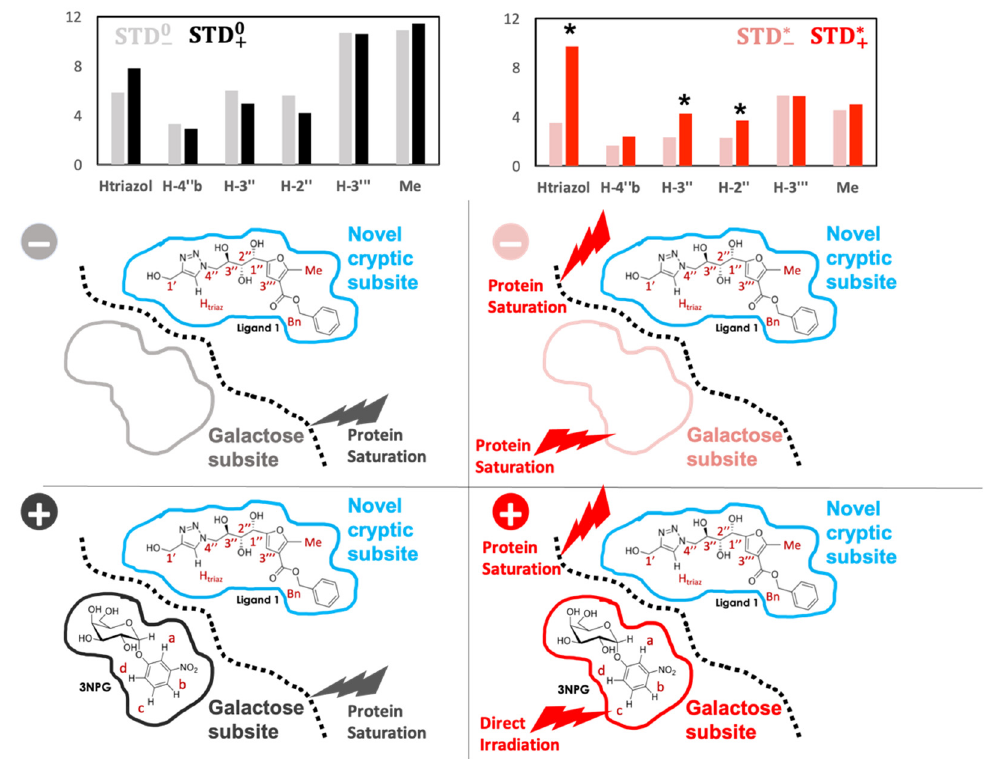
Figure 6. Quantitation of the STD 0 and STD* results (left and right panels, respectively; δ 0 = 0 ppm (in black) and at δ * = 7.27 ppm (in red)) for the IL-STD NMR study of the binding of 3NPG and 1 to CTB. Dark and light black bars show the STD 0 values in samples containing the binary (STD 0 − , 3NPG absent) or the ternary complex (STD 0 + , both ligands present), whereas dark and light red bars show the STD* values in samples containing the binary (STD ∗ − ) or the ternary complex (STD ∗ + ). Asterisks mark the STD intensities significantly increased under direct irradiation of 3NPG. Panels at the bottom represent schematically the 4xSTD NMR experiments. η ( IL − STD ) values are reported in Table S4. *: direct